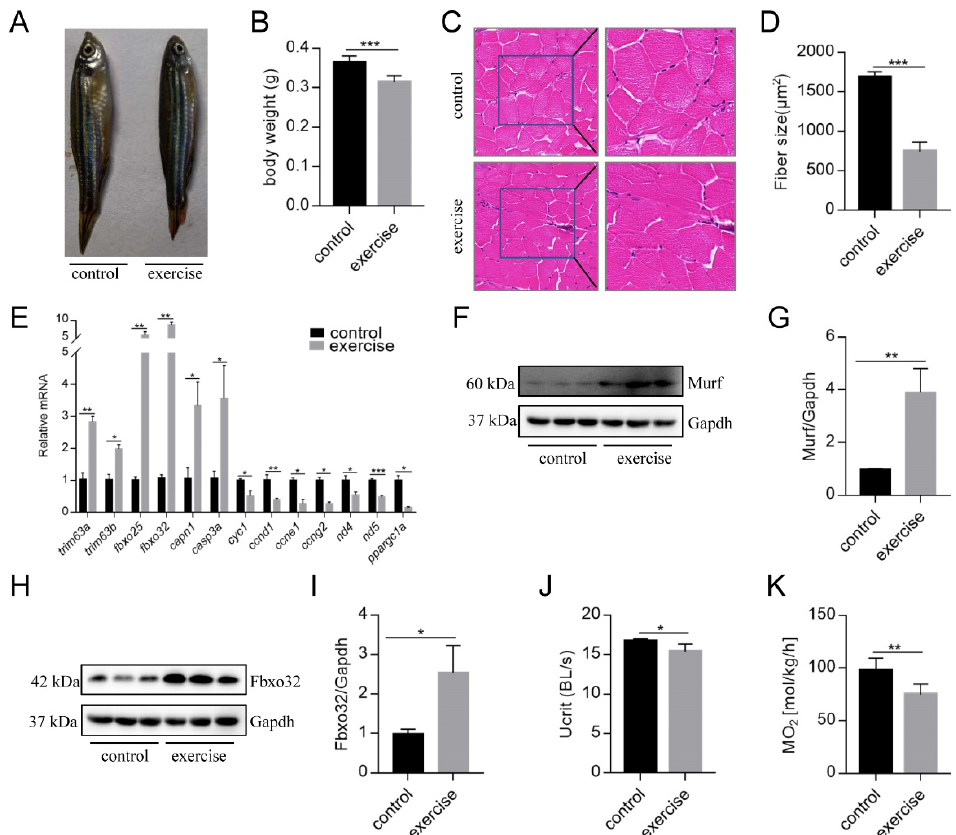
Figure 1. Excessive exercise causes skeletal muscle atrophy in zebrafish. ( A ) Representative image of excessive exercise and control zebrafish. ( B ) Changes in the body weight of zebrafish with or without excessive exercise over a 4-week period. ( C ) Representative photomicrographs of muscle sections stained with H&E. Scale bars = 20 µ m. ( D ) Average fiber size (based on H&E staining). ( E ) The expression of muscle-atrophy-related genes ( trim63a , trim63b , fbxo25 , fbxo32 , capn1, and casp3a ), cyclin ( ccnd1 , ccne1, and ccng2 ), mitochondrial function markers ( cyc1 , nd4 , and nd5 ), and ppargc1a in muscle tissue detected using real-time PCR. ( F – I ) Western blot analysis of Murf and Fbox32 proteins (representative blot). All uncut western blot images are provided in Supplementary Materials. Data represent mean ± SD ( n = 6). ( J , K ) The critical swimming speed (U crit ) and oxygen consumption (MO 2 ) were measured using the Loligo System. * p < 0.05, ** p < 0.01, and *** p < 0.001.